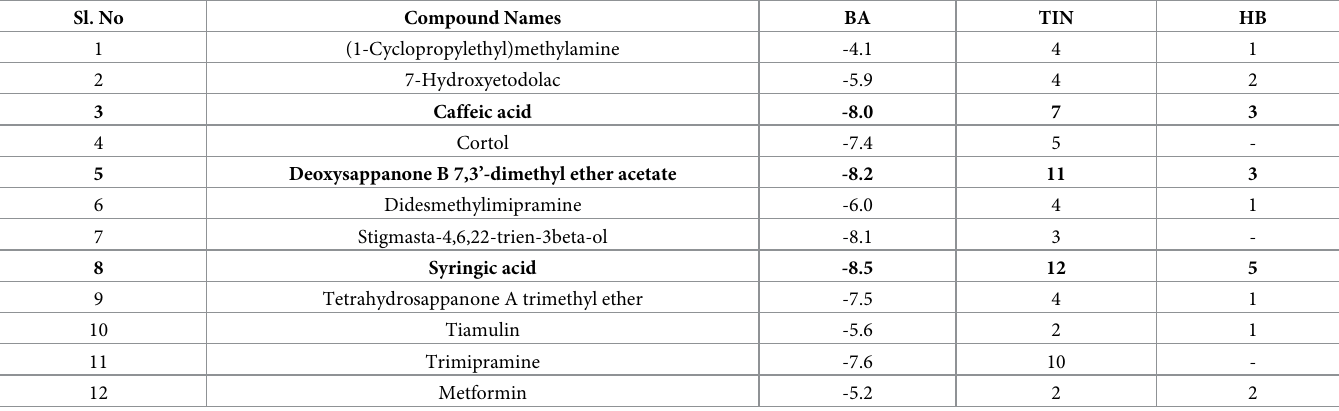
Table 2. Virtual screening results selected phytocompounds of JME docked with the human MAPK3. Sl.